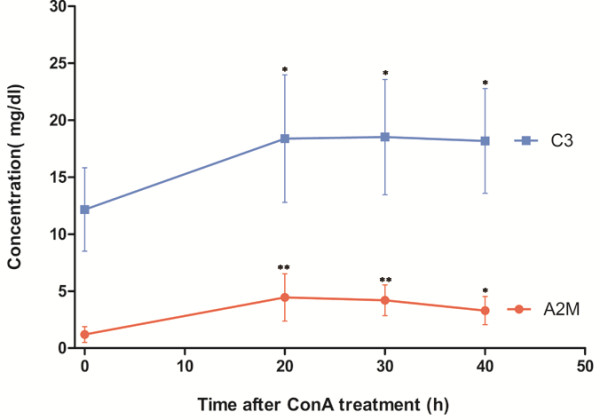
Serum Levels of C3 and A2M in AIH mice with ConA treatment for different times. In each group, six mice were treated with ConA from 0–40 h (n = 6). *P <0.05, **P < 0.01 (AIH mouse serum versus control serum). Data were shown with the mean value and SD.